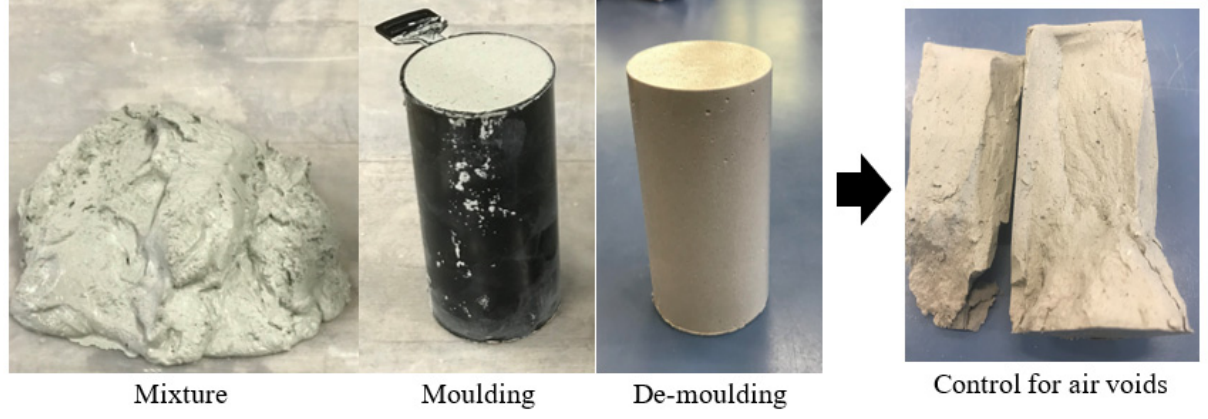
Figure 2. Geopolymer-treated clay specimen.